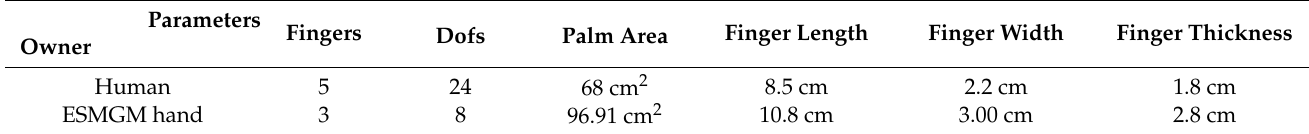
Table 1. Comparison between ESMGM robot hand parameters and human hands.